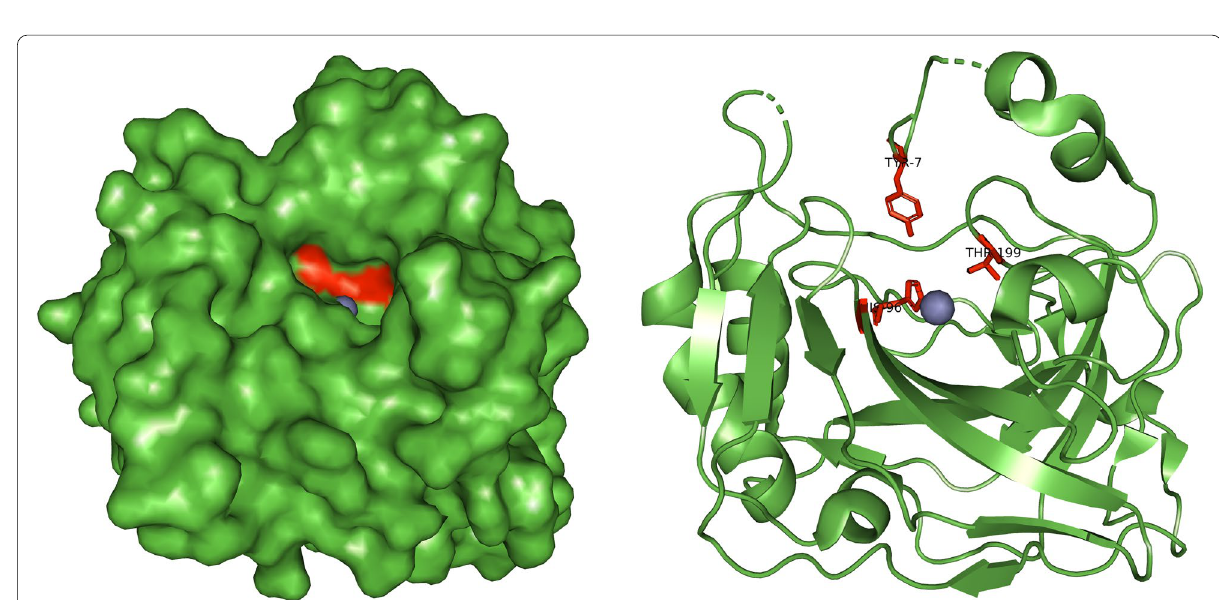
Fig. 7 Amino acids that form the active site of human carbonic